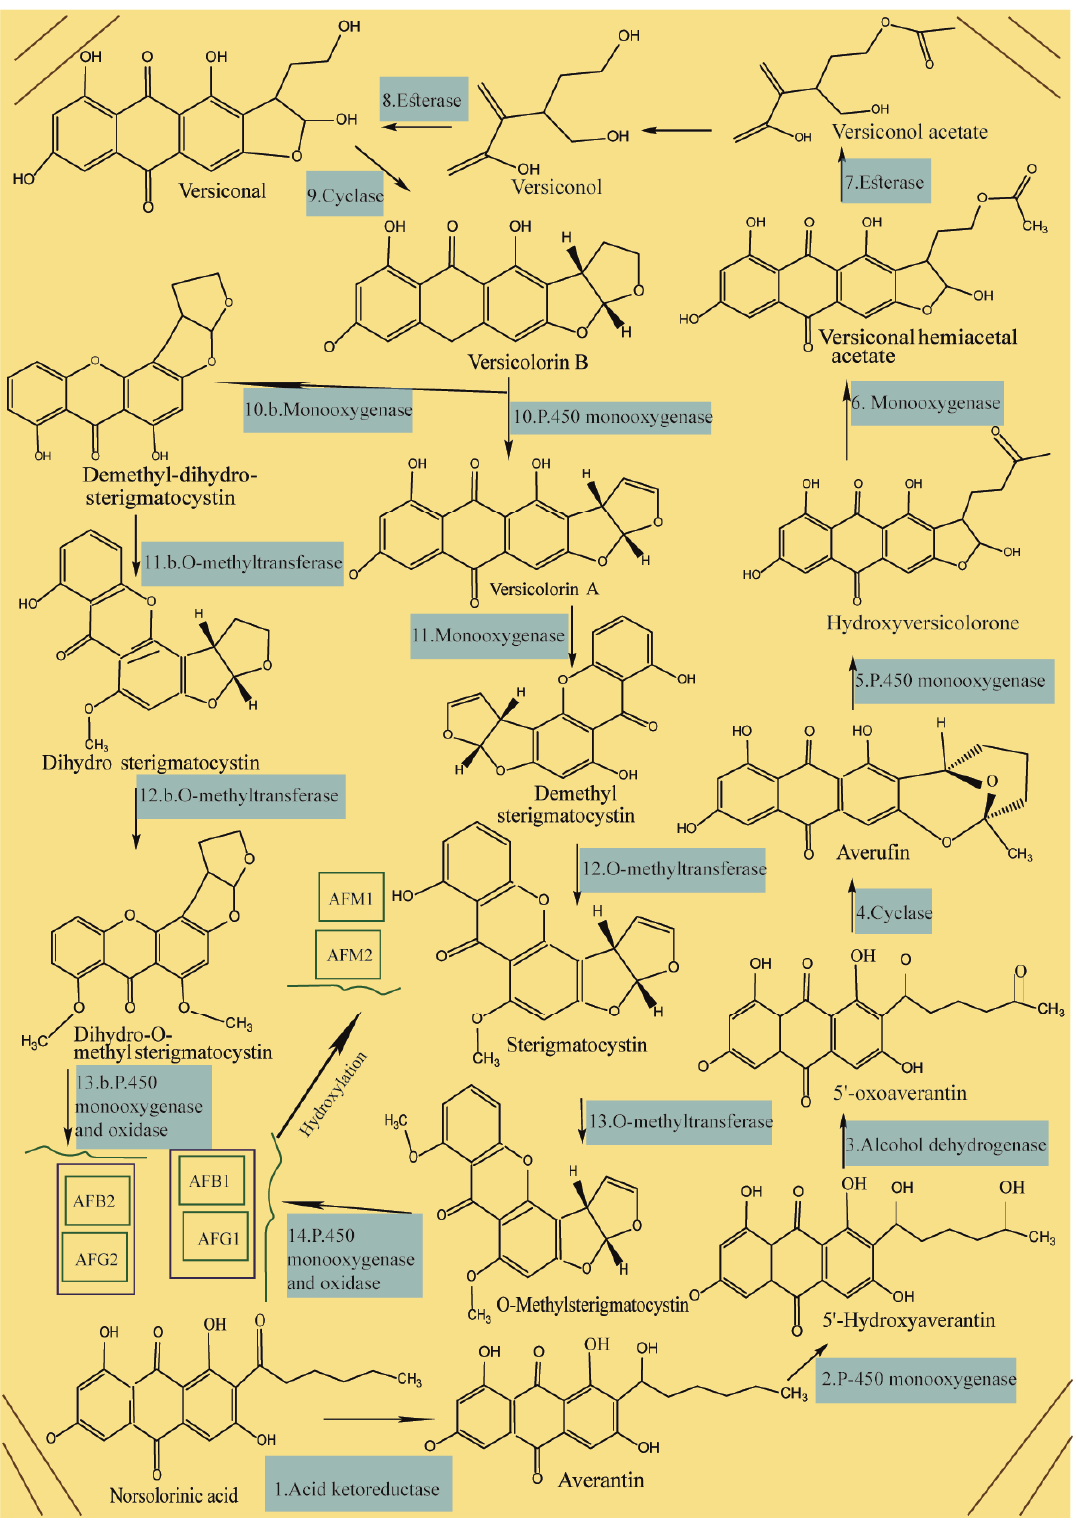
Figure 1. Overview of aflatoxins’ biosynthesis.